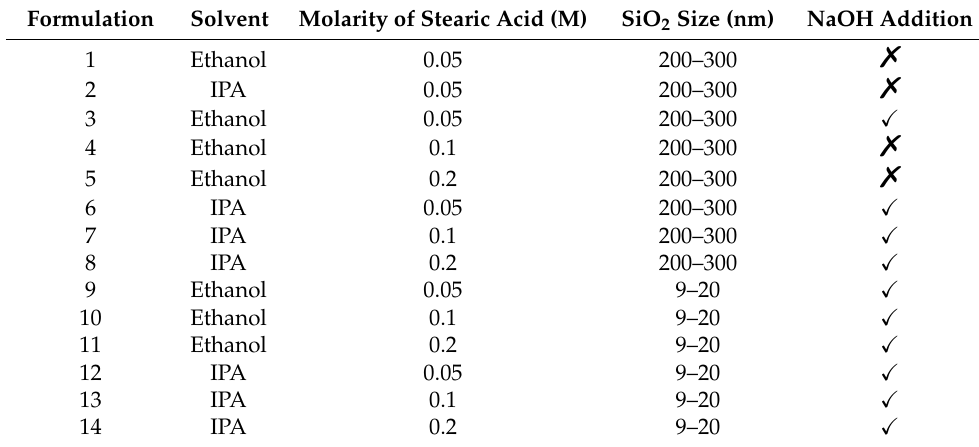
Table 1. Formulations used to produce hydrophobic